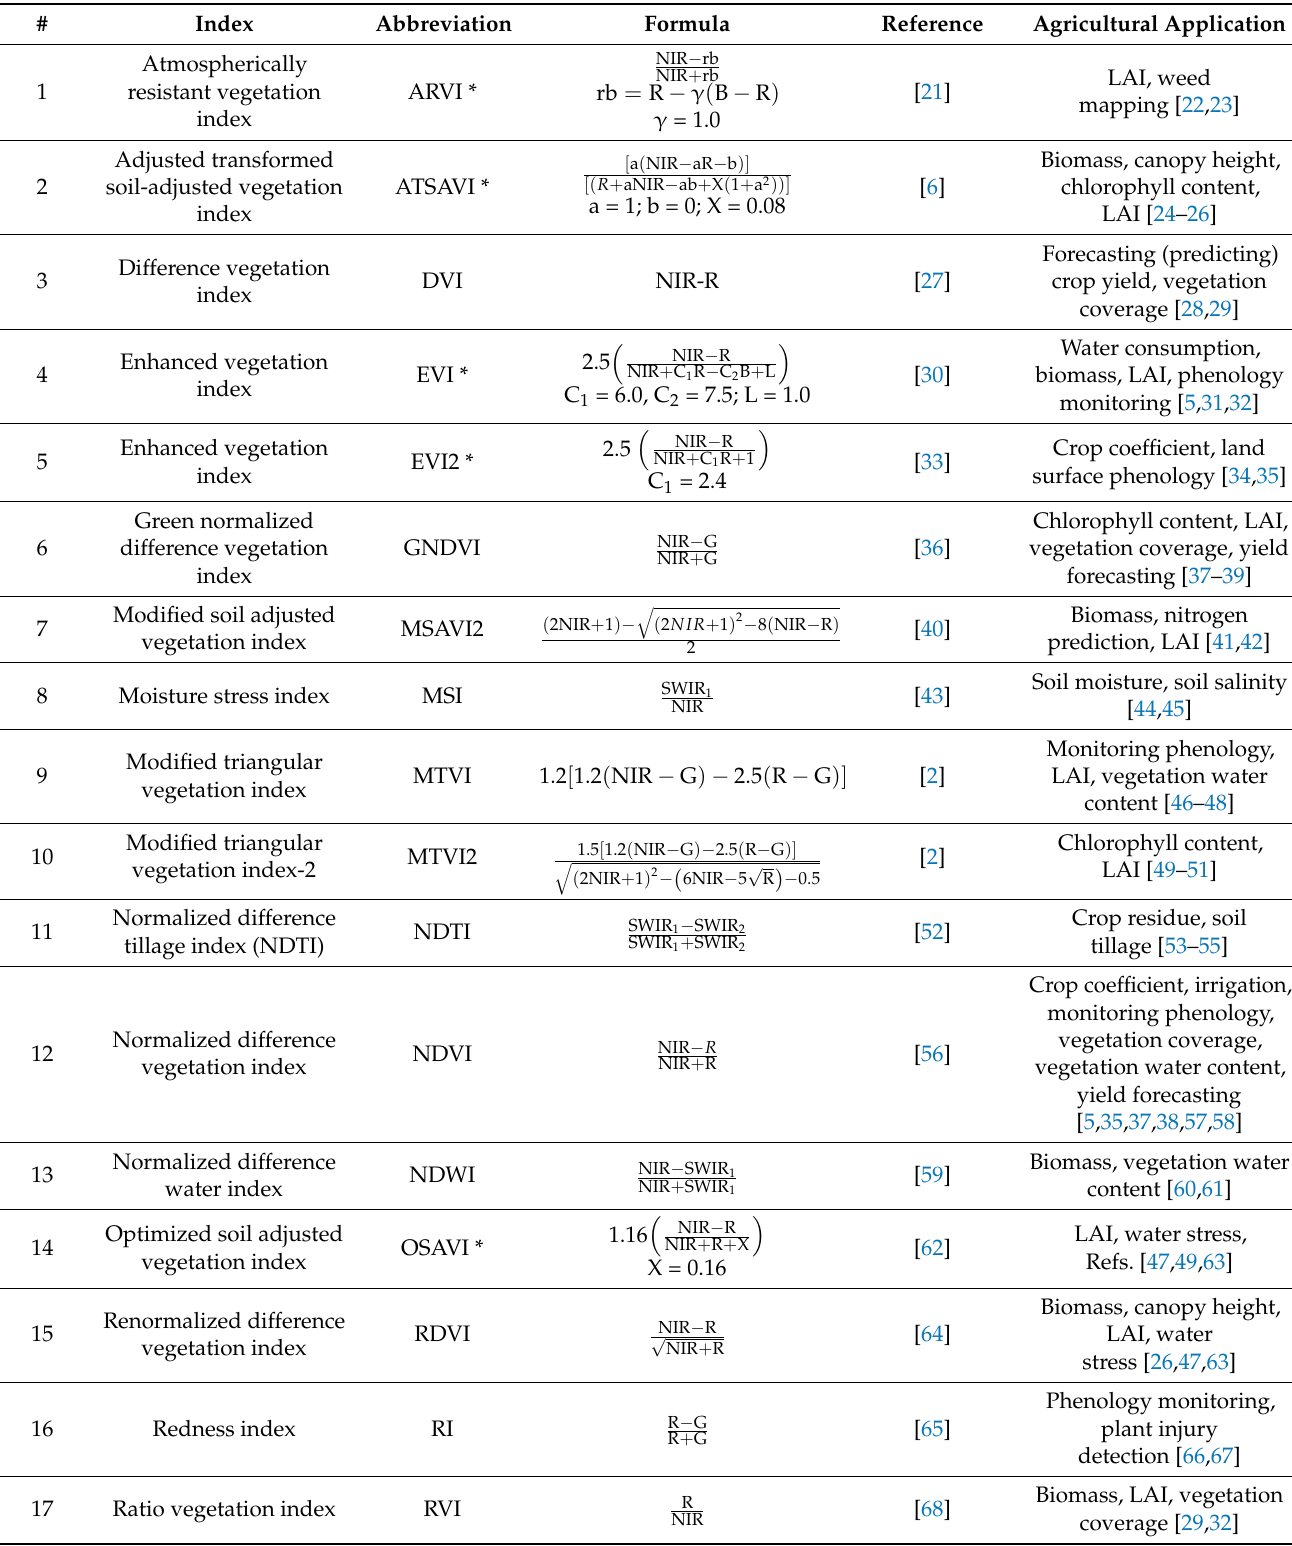
Table 2. Vegetation indices commonly used in agricultural applications and considered in the VICAL